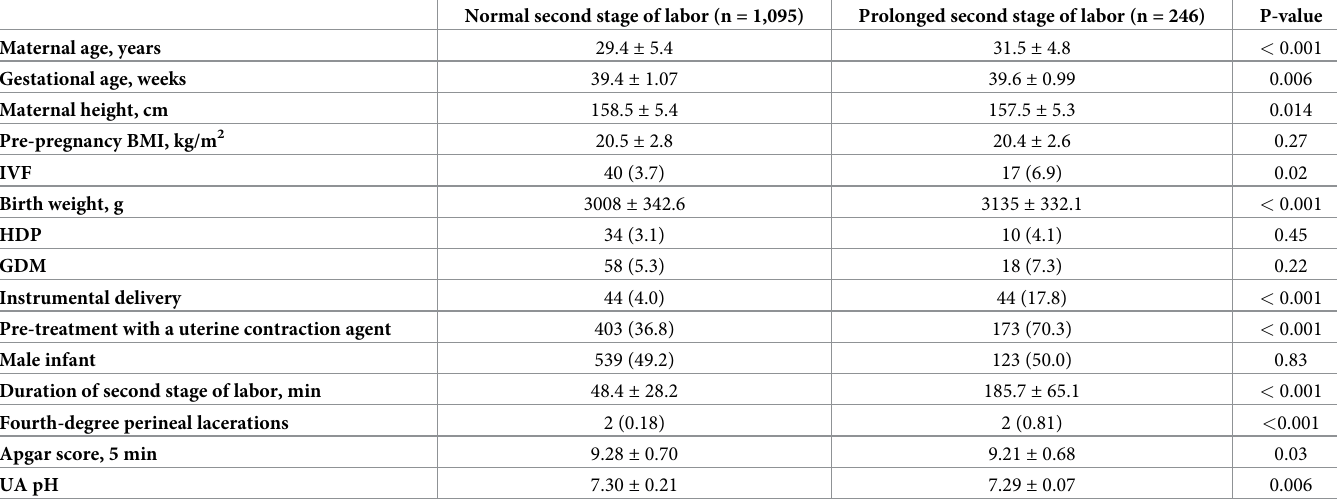
Table 3. Baseline characteristics of nulliparous women in the study